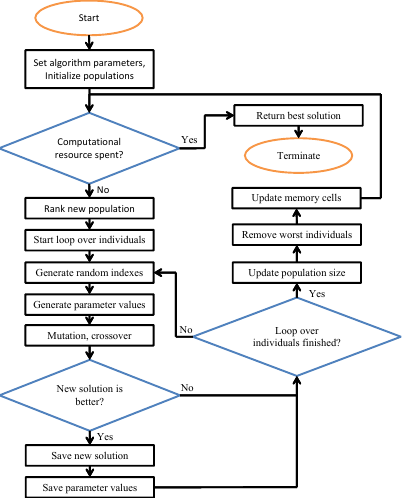
Figure 1. Flow chart of the L-NTADE